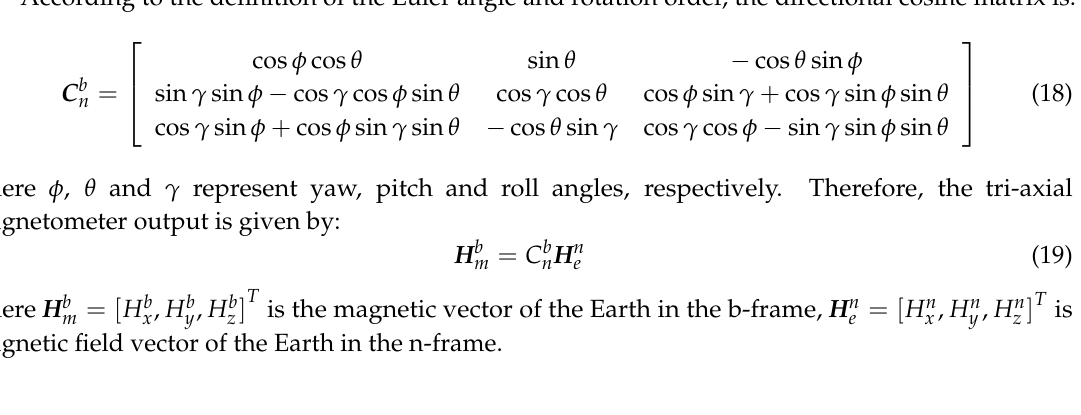
Figure 24. Definition of coordinate frame.